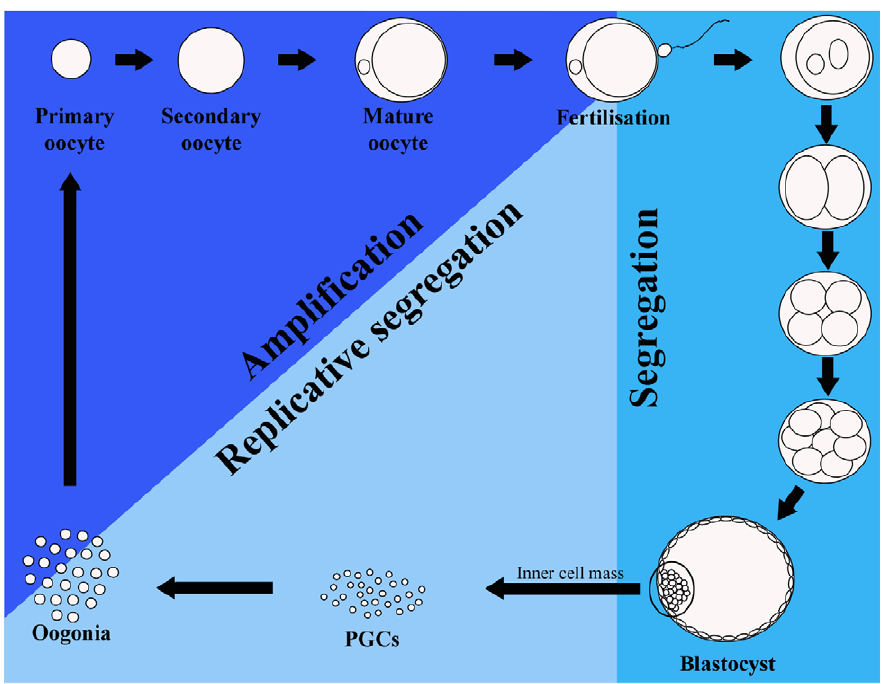
Figure 2. Mitochondrial DNA (mtDNA) cycle in the mouse germline. During early embryo development (‘‘Segregation’’ on the diagram, representing the first seven to eight days after fertilization) the mtDNA is segregated among daughter cells without being replicated. The number of mtDNA copies thus decreases drastically, being lowest in primordial germ cells (PGCs). The next stage is marked ‘‘Replicative segregation,’’ which implies random replication and partitioning of mtDNAs into daughter cells. The last stage, ‘‘Amplification,’’ is characterized by an exponential amplification of mtDNA molecules. It has been suggested that replication of mtDNA during this stage is restricted to a sub-group of molecules leading to drastic changes in the mtDNA genotype in the mature oocyte. Yet, there seems to be during this stage a selection against mutations in the mtDNA that might occur.